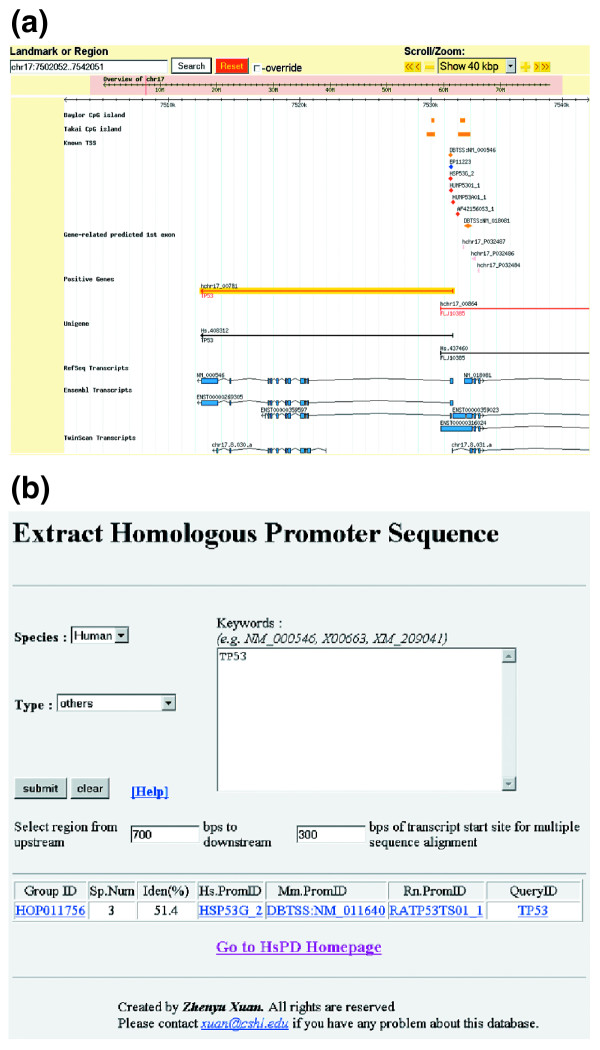
Screen shots of the CSHLmpd user interface. (a) Gbrowse for genome-wide gene and promoter display. (b) Homologous promoter search and analysis.